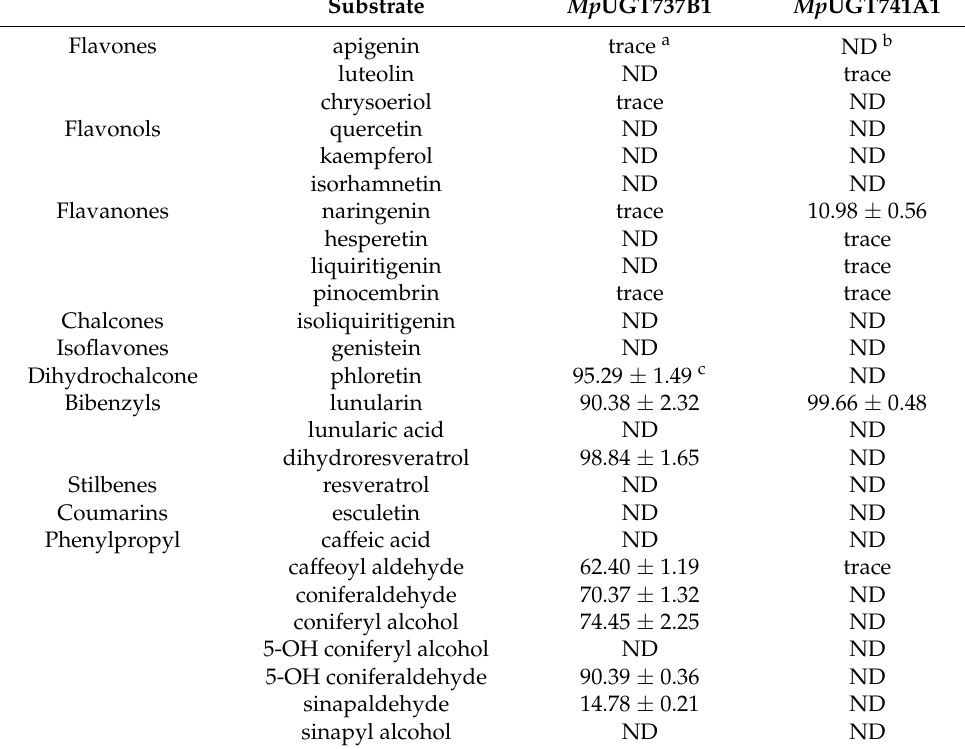
Table 1. Conversion rates of substrates catalyzed by Mp UGTs with UDP-glucose as the sugar